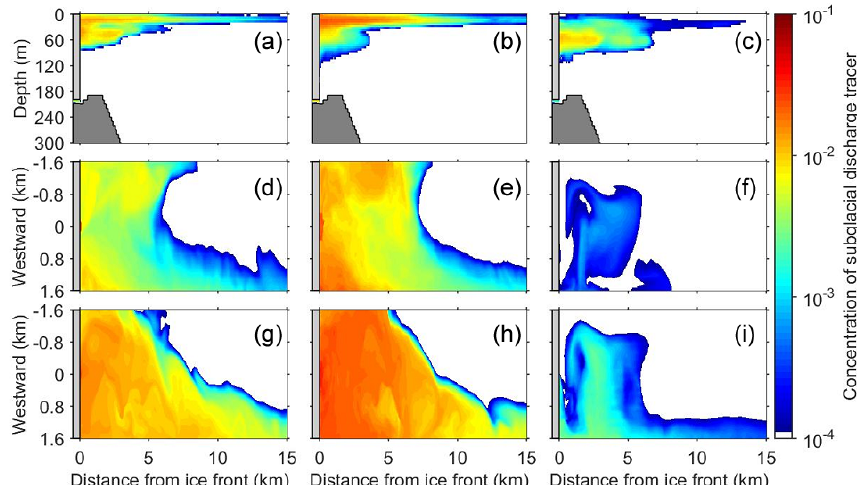
Figure B1. (a–c) Cross-fjord averaged concentration of the subglacial discharge tracer. Horizontal distribution of the tracer concentration (d– f) at the fjord surface (depth: 0–5m) and (g–i) at a depth of 10–15m. Experimental results are obtained (a, d, g) in CTRL after integration for 62h (b, e, h) in Q100 after 33h, and (c, f, i) in Q10 after 153h. The integration time in each experiment is equivalent to the time required for the first arrival of the